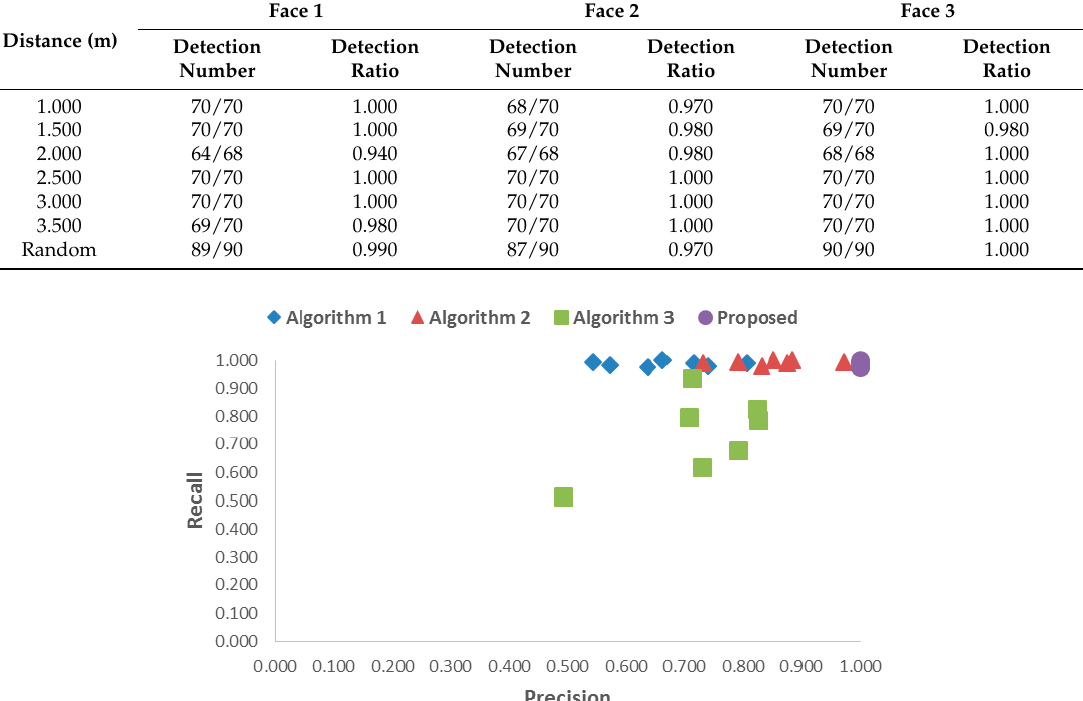
Table 3. Identification number and ratio for multiple users with the proposed algorithm.